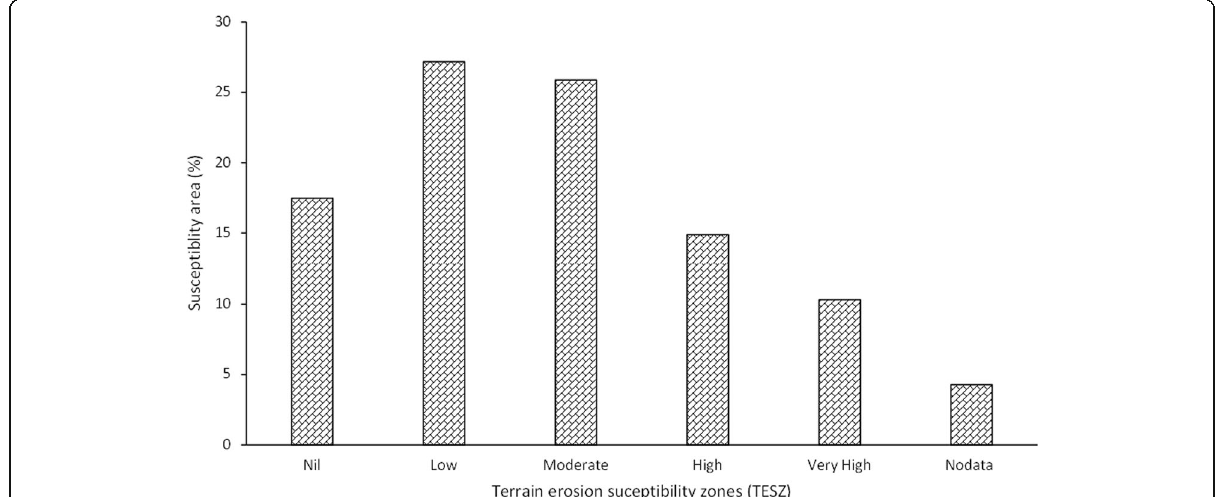
Fig. 5 Area distribution of terrain erosion susceptibility